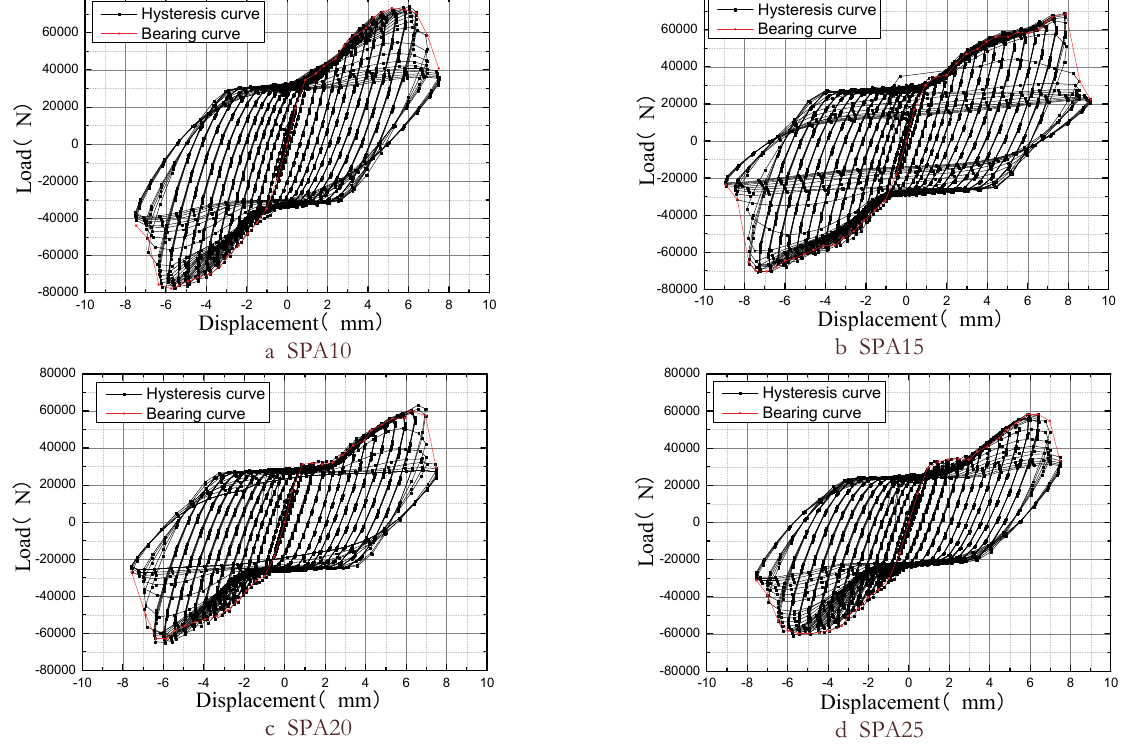
Figure 6: Hysteresis curves of dampers for SPA with different opening